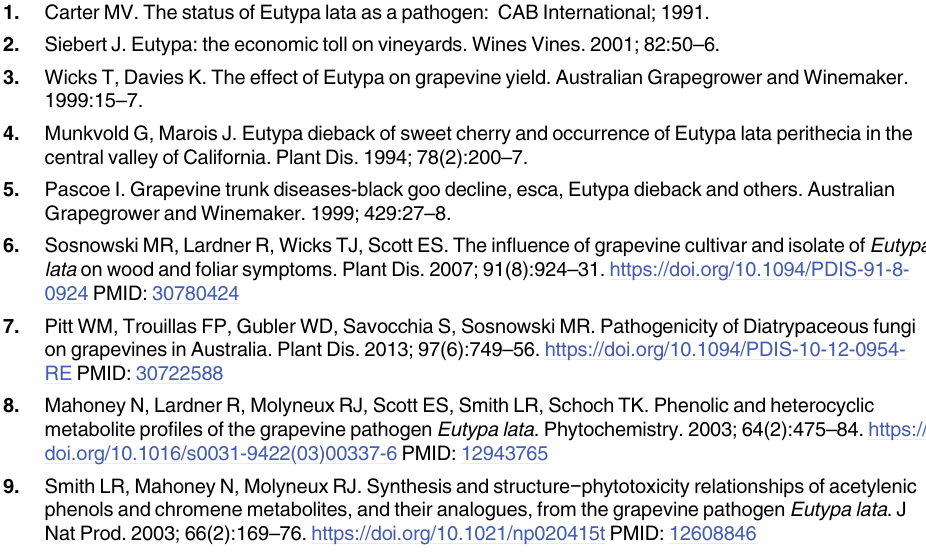
S6 Table. Predicted secondary metabolite gene clusters in the long-read assembly of four Eutypa lata isolates. S7 Table. Presence/absence of the top significant k-mer and mycelium recovery phenotype for 25 Eutypa lata